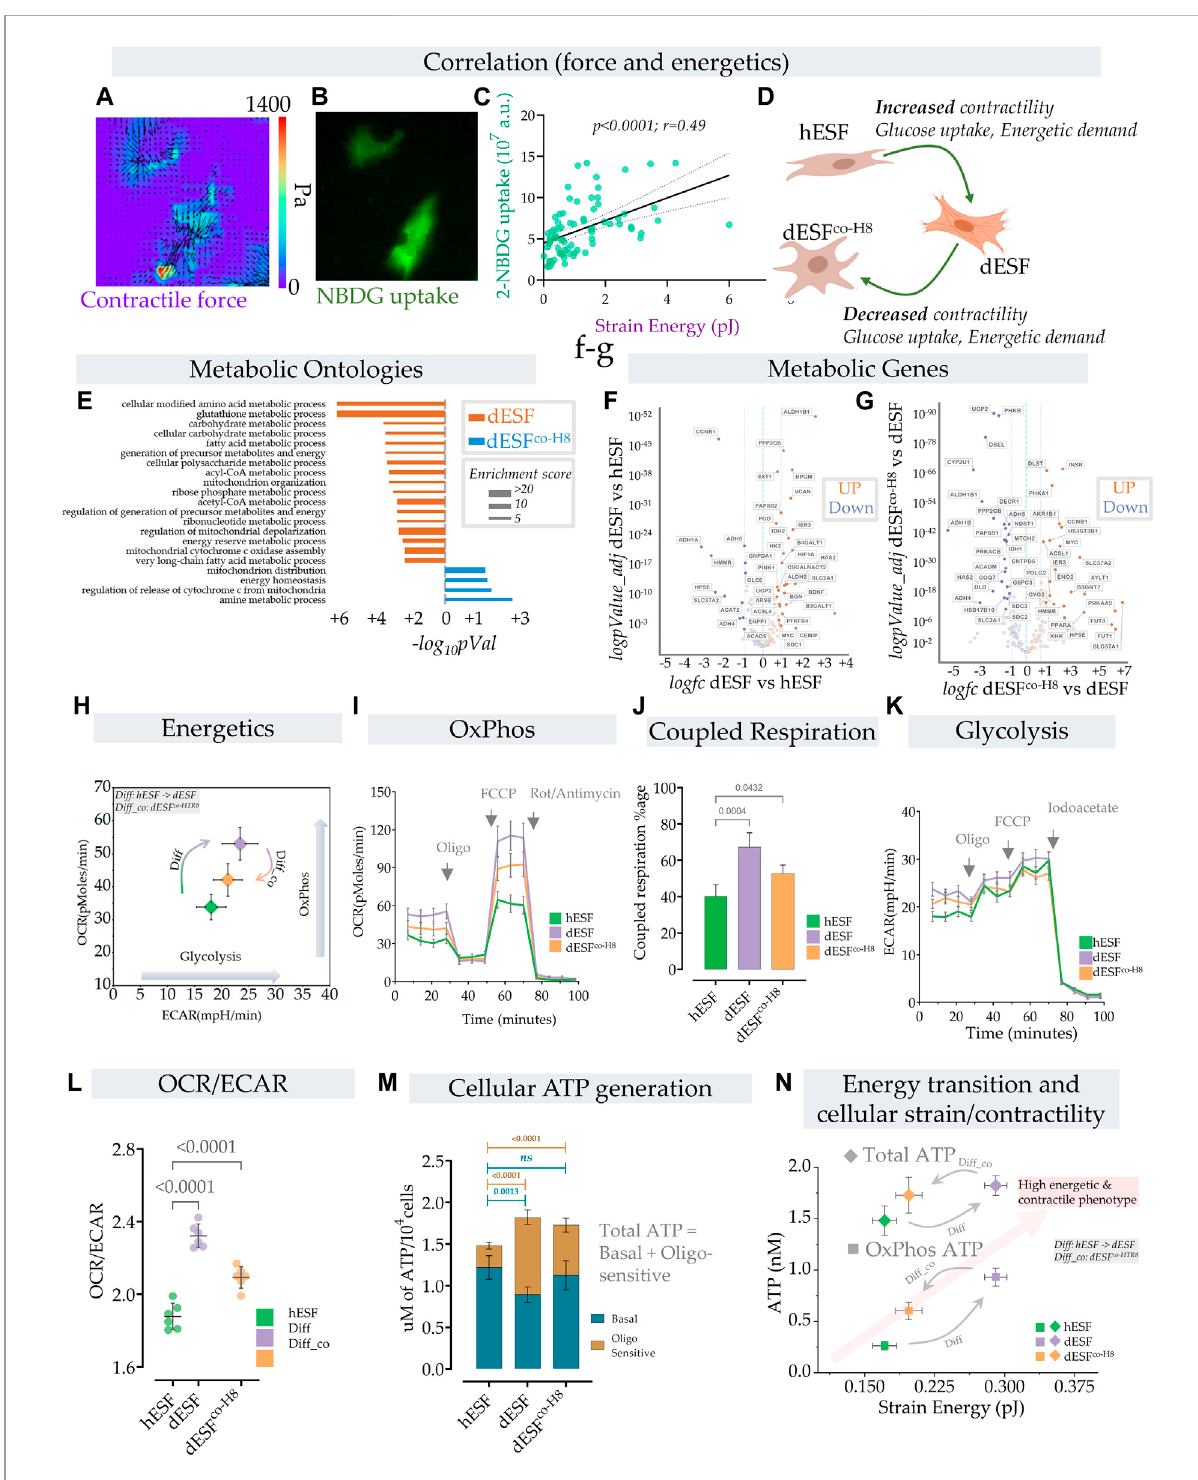
FIGURE 2 Energetic transition in decidual ESF re fl ect changes in contractility which is reversed by EVT. (A – D) Traction force microscopy and glucose uptake: (A) Glucose uptake was monitored within a population of decidualized ESFs (dESF) with NBDG along with cellular contractility, Representative fi gure of two contracting cells with (A) traction force vector maps and (B) NBDG fl uorescence (B) ; (C) Correlation of strain energy of contracting cells and glucose uptake; n > 70. (D) Schematic showing increased contractility, glucose uptake, and energetic demand in decidualized cells (dESF) that is reduced with co-culture (dESF co − H8 ). (E) Metabolic ontologies that are activated in dESF or dESF co − H8 with their